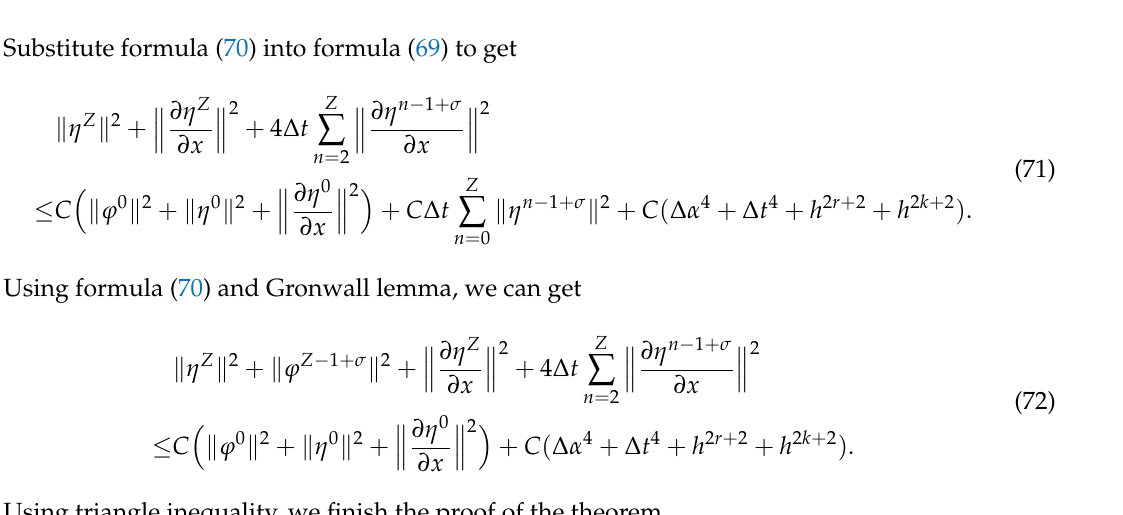
Table 1. The errors and convergence rates in time with ∆ α = 1